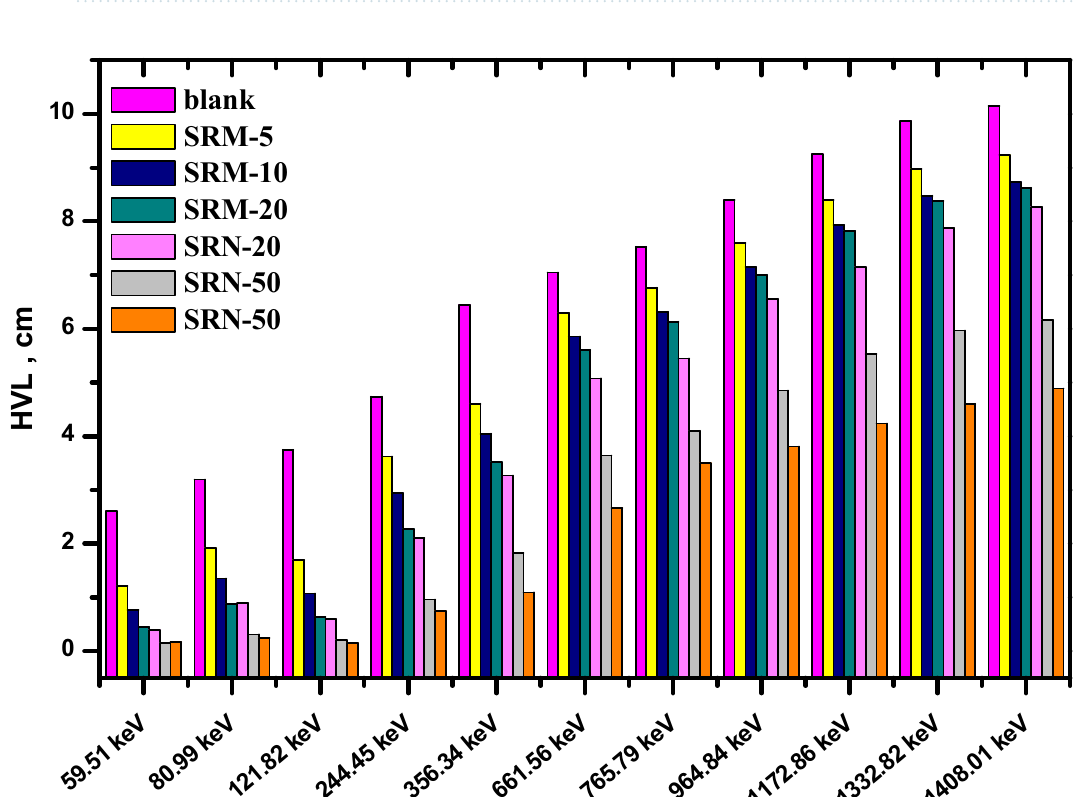
Figure 9. HVL of pure silicon rubber, micro, and nano PbO at different